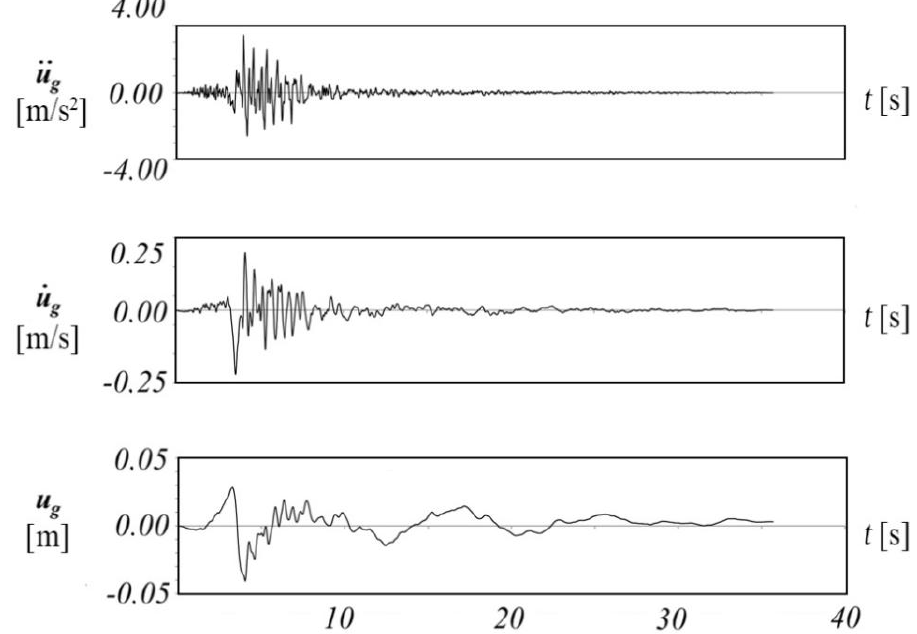
Figure 13. Ground motion assigned to the shaking table.